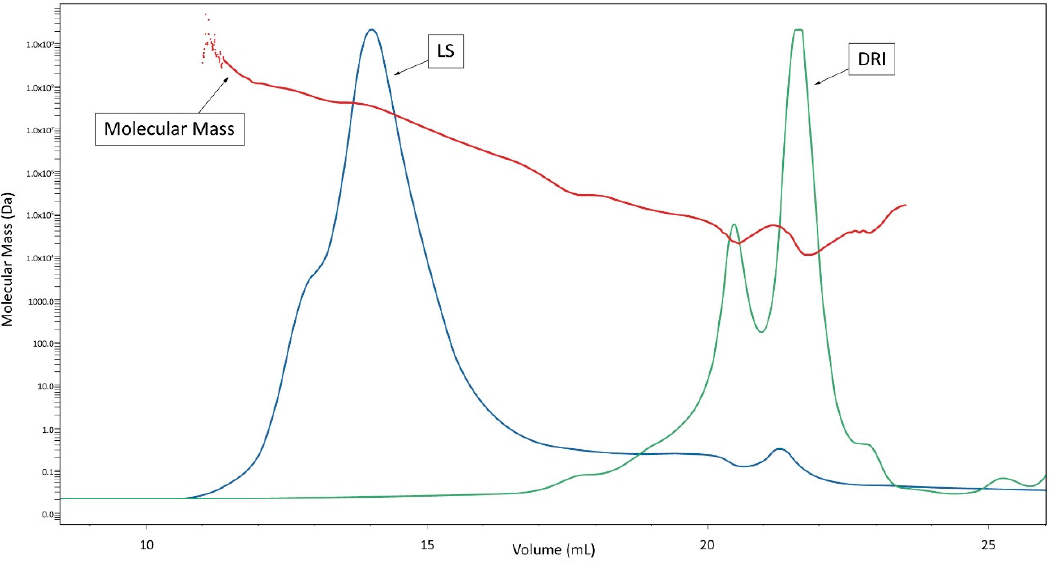
Figure 1. Steric exclusion chromatography/multi-angle light scattering/differential refractive index (SEC/MALS/DRI) analysis of Pleuran CCWE (DRI = differential refractive index, LS = light-scattering signal). The profiles shown are representative of two independently obtained extracts.